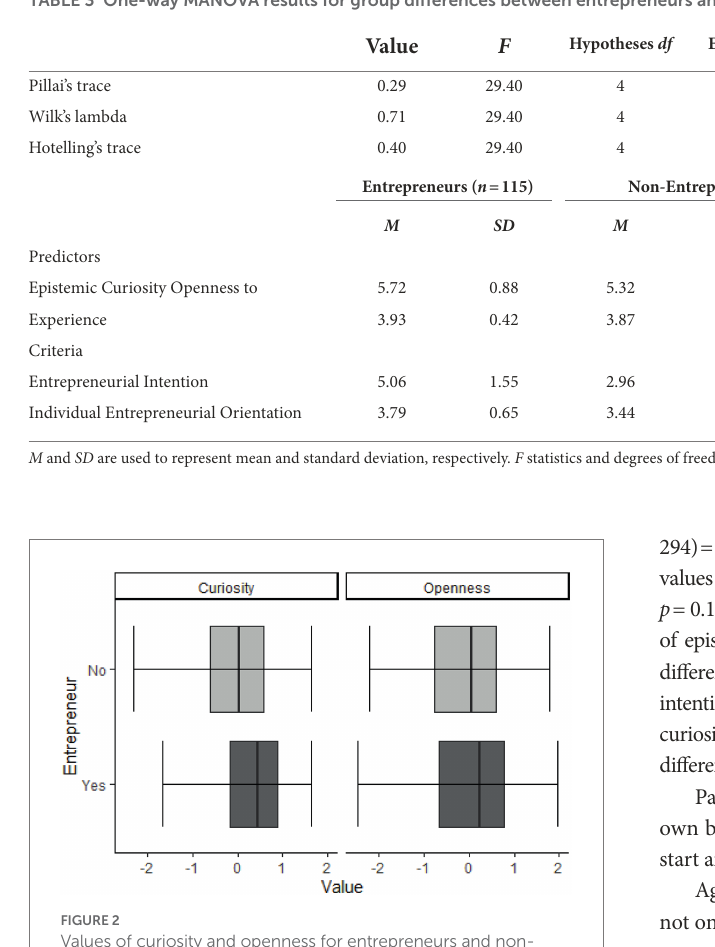
FIGURE 2 Values of curiosity and openness for entrepreneurs and non- entrepreneurs. Boxplots mark the median for each group and interquartile range for the standardized values of openness to experience and epistemic curiosity, respectively. Non- entrepreneurs in light gray, entrepreneurs in dark